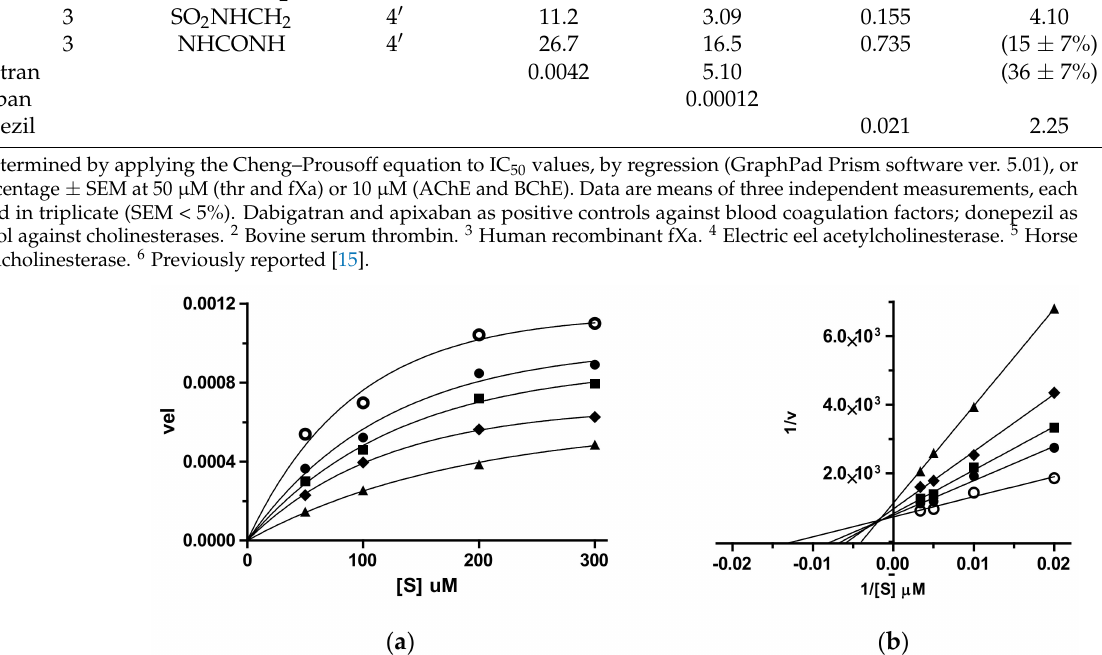
Figure 3. Inhibition kinetics ( a ) and Lineweaver–Burk plot ( b ), r 2 = 0.966–0.996 for ee AChE (0.09 U/mL) and 1 (0–500 nM) by using different substrate (acetylthiocholine iodide) concentra- tions (50–300 µ M). The replot (r 2 = 0.990) of the slopes versus [I] determined the K i (58 nM) as the x -axis intercept (see Supplementary Information). ( (cid:35) ( π ) 500